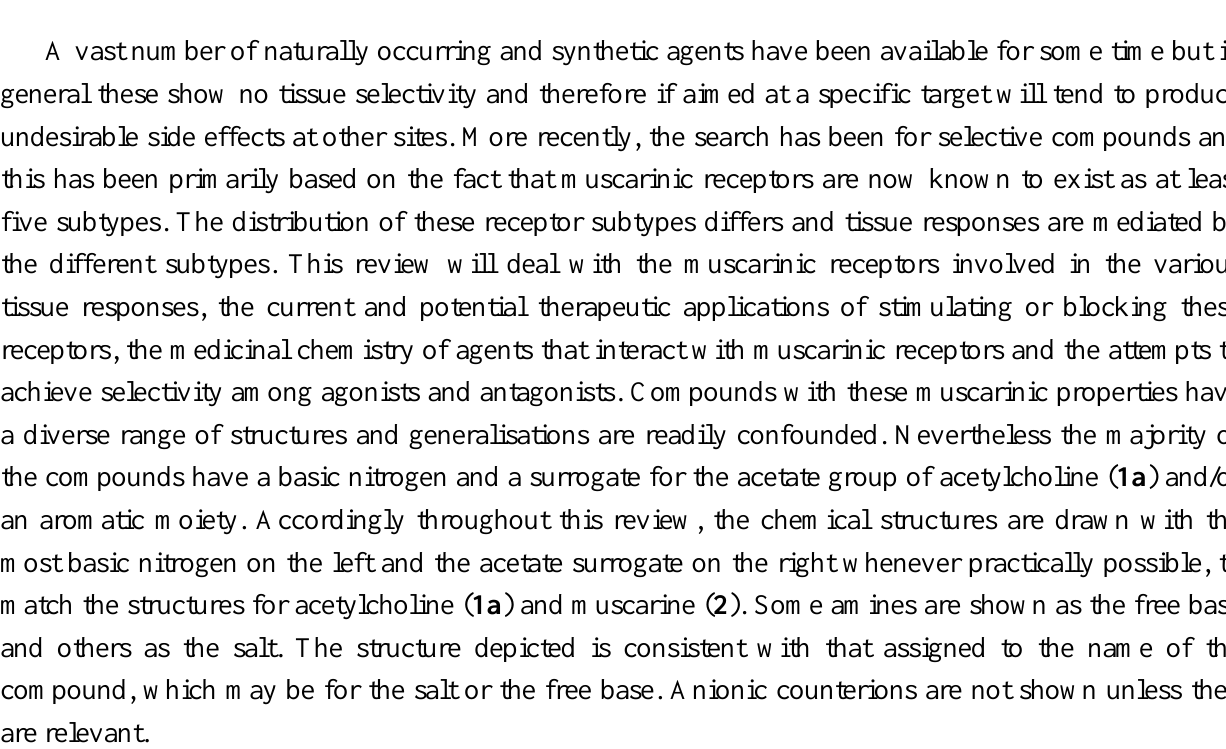
Figure 1 Muscarinic receptors at different locations along the autonomic parasympathetic efferent pathway. Acetylcholine (Ach) released from the preganglionic varicosity can , muscarinic M and muscarinic M receptors to produce a fast interact with nicotinic N N 1 2 depolarisation (fast EPSP), a slow depolarization (slow EPSP) and hyperpolarization (IPSP), respectively. Nicotinic receptor stimulation sets up the action potential in the postganglionic neurone to release Ach from parasympathetic nerve terminal varicosities. or M receptors in smooth This can interact with M 2 3